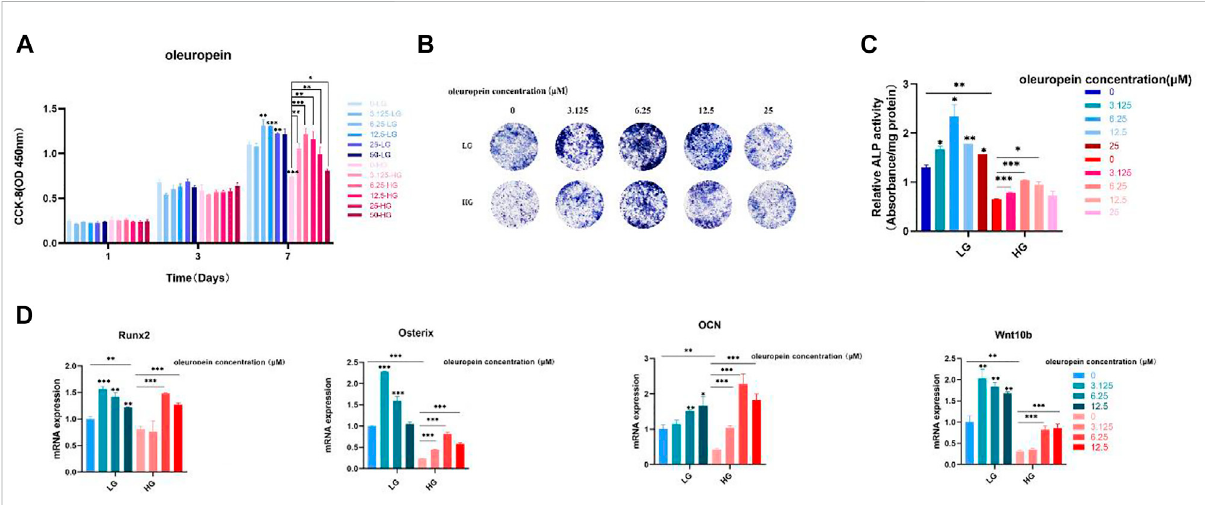
FIGURE 8 Oleuropein reverses the osteogenic suppression of BMSCs under the high glucose microenvironment. (A) CCK-8 analysis. (B) ALP staining. (C) Semi-quantitative analysis of ALP. (D) PCR